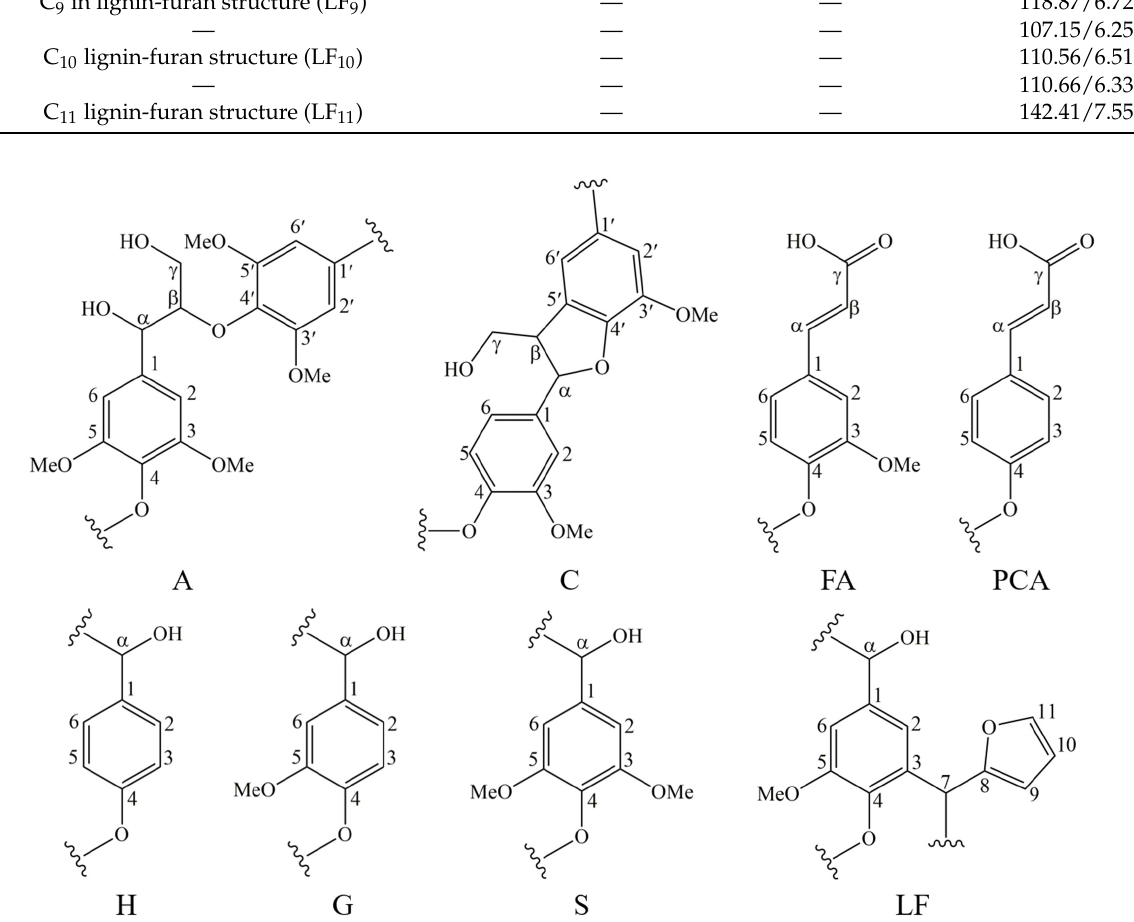
Figure 11. The main structures and linkages in EHL, HEHL, and model compounds: (A) β -O-4 ′ structures, (C) resinol structures formed by β−β′ coupling, (FA) ferulate units, (PCA) p-coumarate units, (H) p-hydroxyphenyl units, (G) guaiacyl units, (S) syringyl units, and (LF) lignin-furan ring structures. The HSQC spectra corresponding to the aliphatic oxygenated regions ( δ C/ δ H